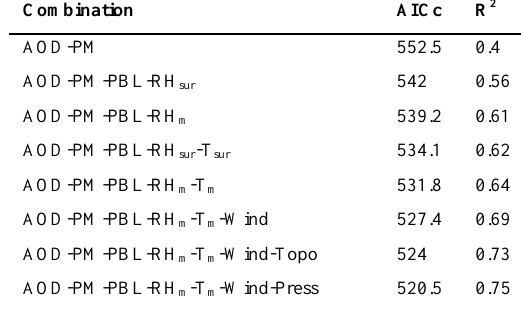
Table2. Assessing of different model combination